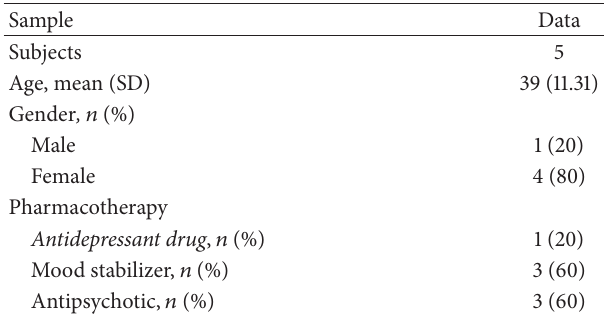
Table 1: Clinical and demographic characteristics of the sample (pilot phase).